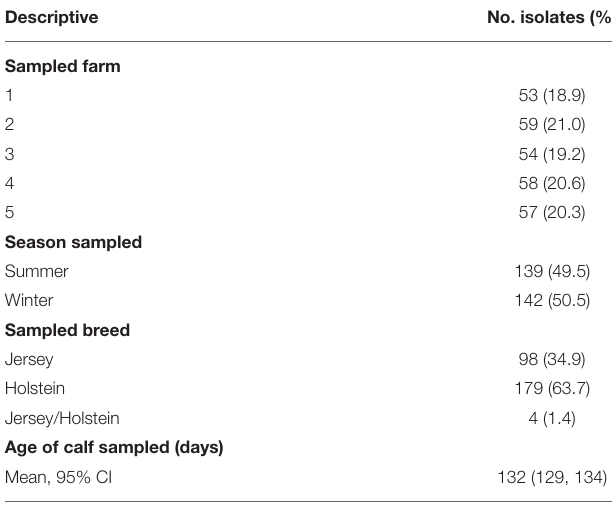
TABLE 1 | Descriptive statistics of isolates included in